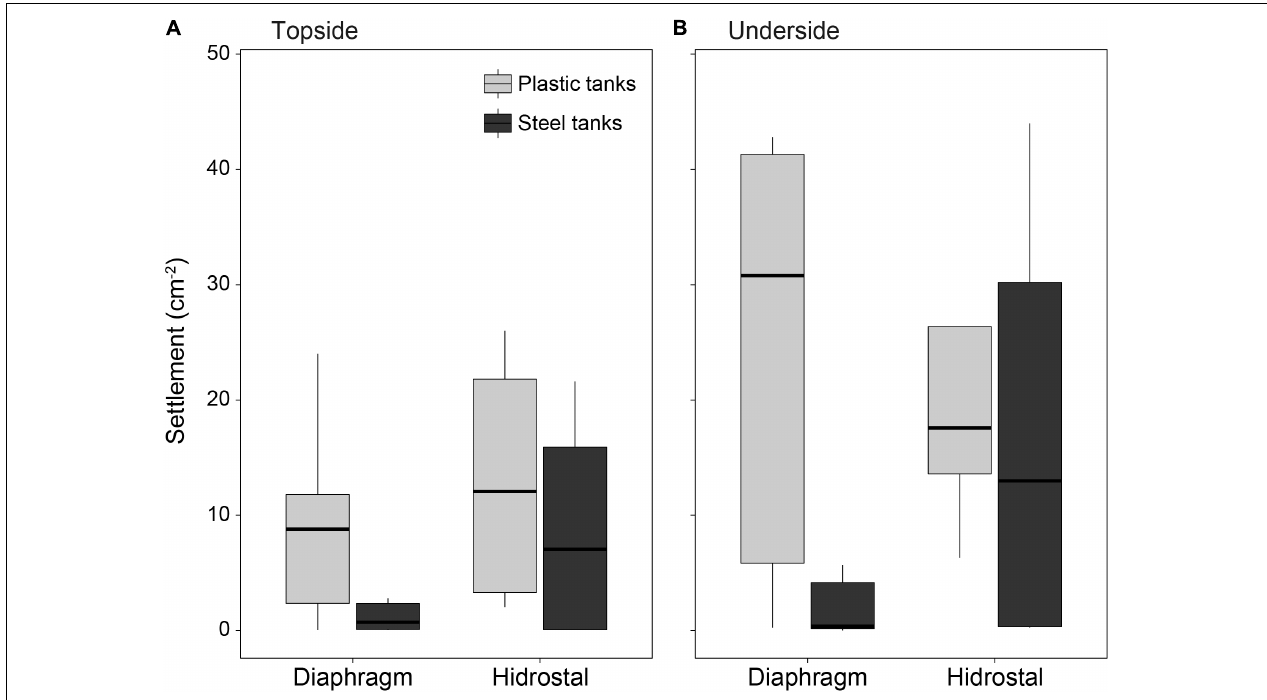
FIGURE 8 | Coral settlement density (cm - 2 ) on tile (A) topsides and (B) undersides placed in the plastic and steel culture tanks. Two 5 × 5 cm settlement tiles were placed in each tank and scored for settlement at 4.5 days following the introduction of embryos into the tanks ( n = 6 per tank type × tile orientation for the diaphragm pump; n = 4 per tank type × tile orientation for the Hidrostal